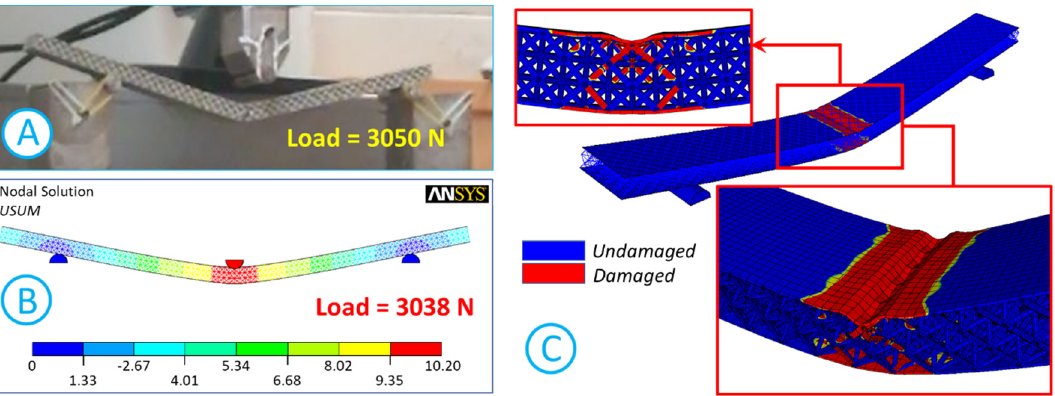
Figure 16. Numerical results of specimen Type02. ( A ) Experimental failure and deformed state; ( B ) global displacement at maximum load; ( C ) Damage status after maximum applied displacement.